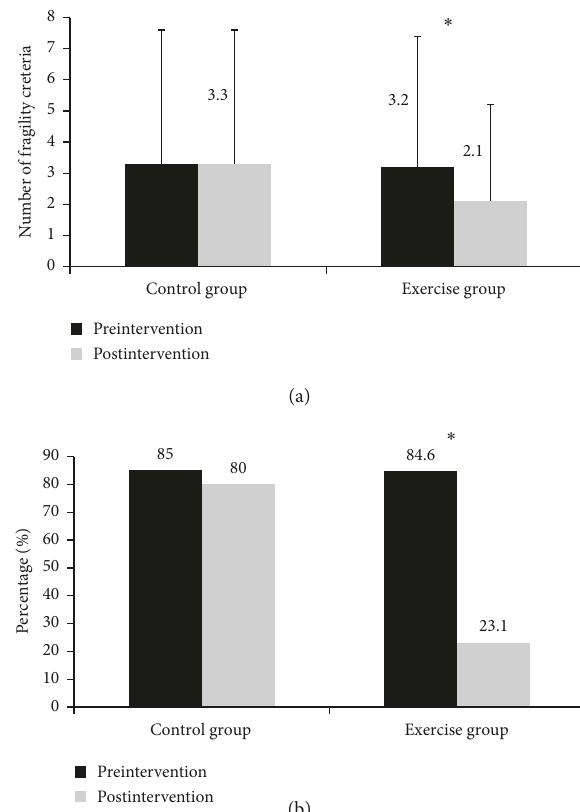
Figure 2: Absolute count of criteria for frailty (a) and proportion of elderly deemed frail and prefrail (b) in the control group and the exercise group. Black bar: preintervention moment; gray bar: postintervention moment. ∗ p < 0 .